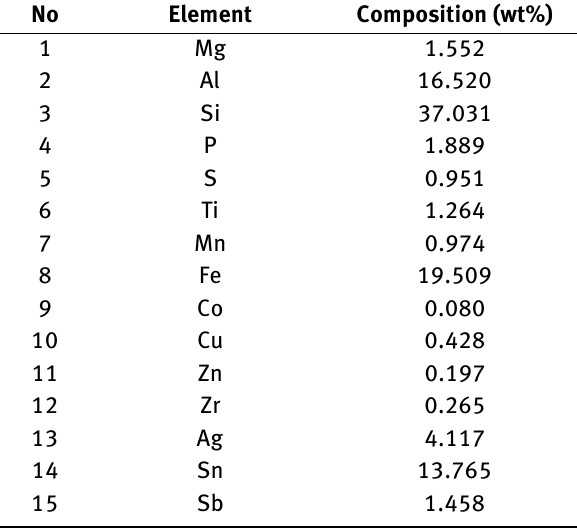
Table 4: Palm Oil Boiler Ash Nanoparticle Elements Contents